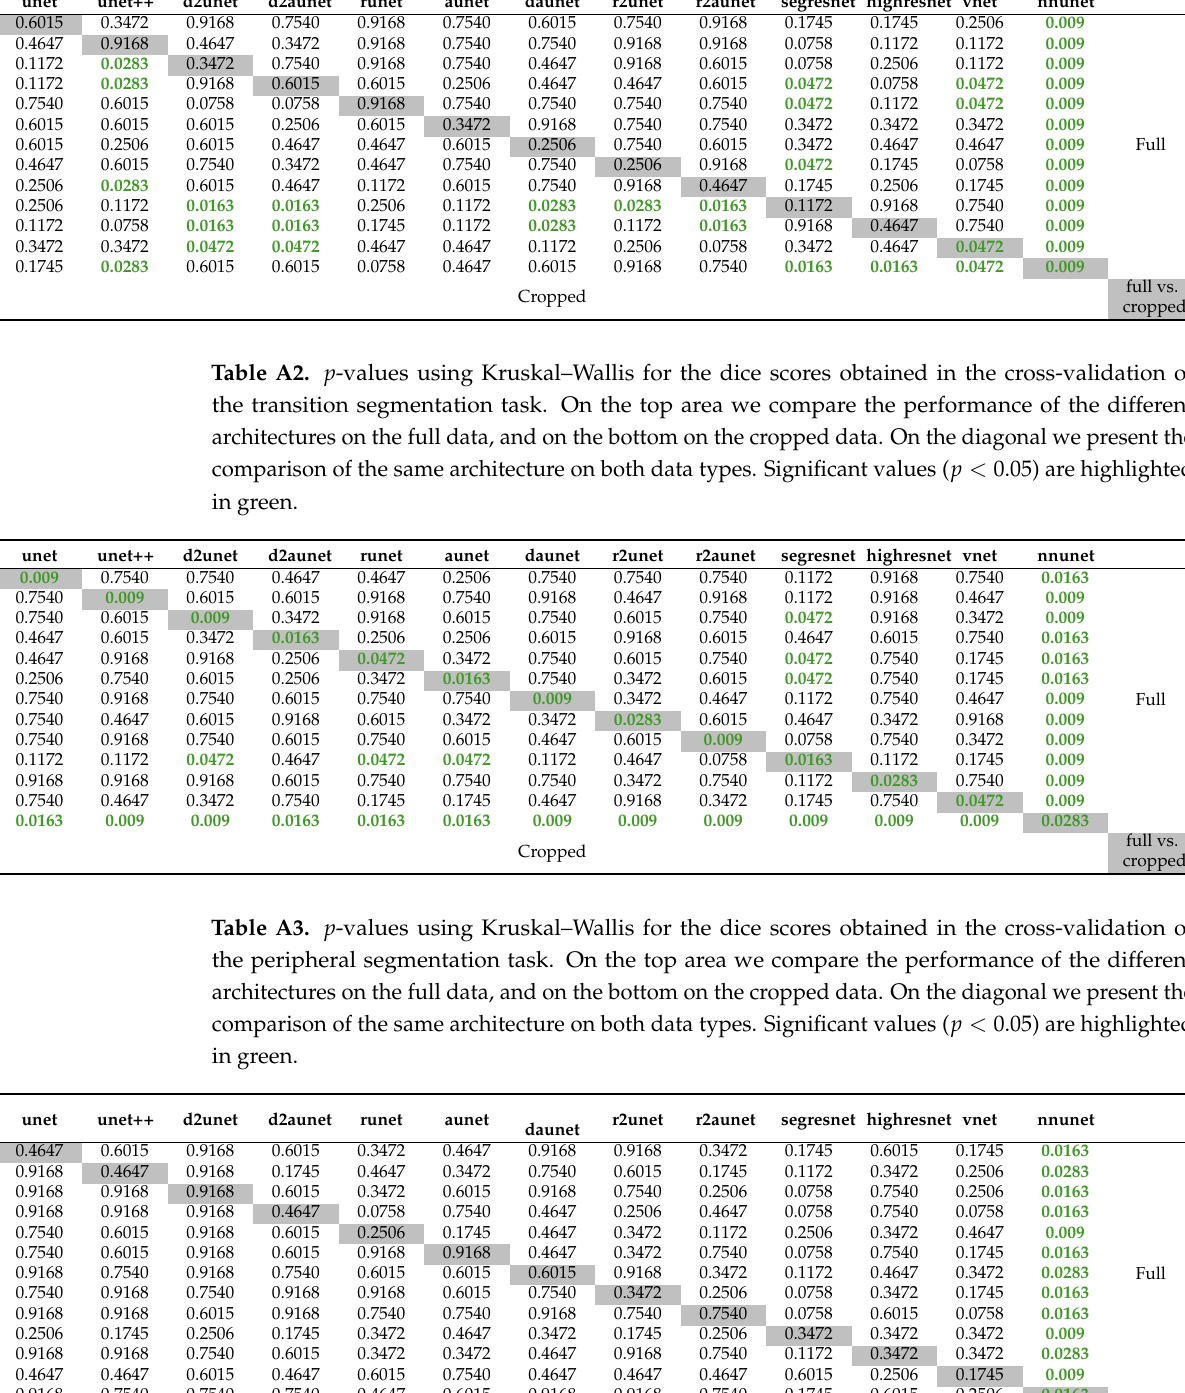
Table A1. p -values using Kruskal–Wallis for the dice scores obtained in the cross-validation of the gland segmentation task. On the top area we compare the performance of the different architectures on the full data, and on the bottom on the cropped data. On the diagonal we present the comparison of the same architecture on both data types. Significant values ( p < 0.05) are highlighted in green.